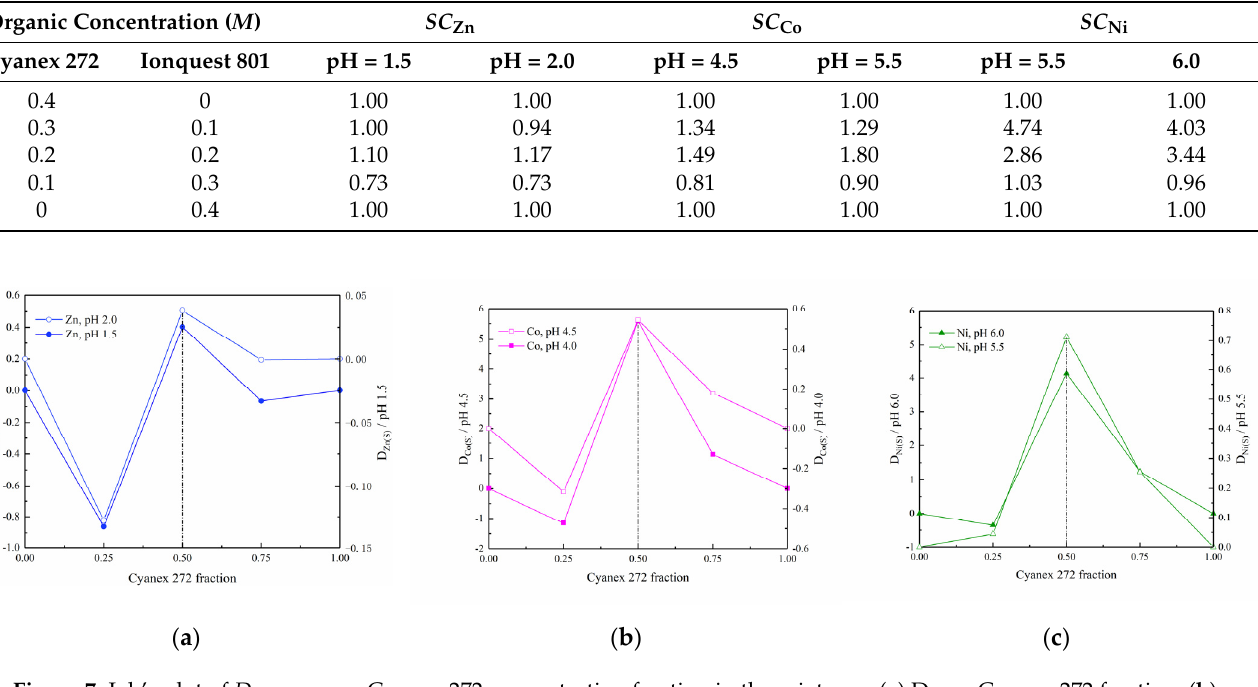
Figure 7. Job’s plot of D M(S) versus Cyanex 272 concentration fraction in the mixtures. ( a ) D Zn(s) -Cyanex 272 fraction, ( b ) D Co(s) -Cyanex 272 fraction, ( c ) D Ni(s) -Cyanex 272 fraction.